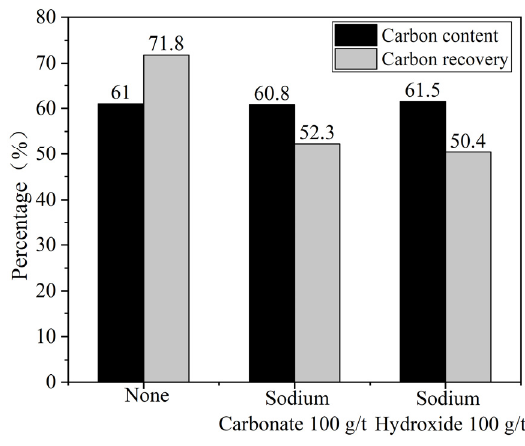
Figure 10. Effect of pH control agents on flotation.